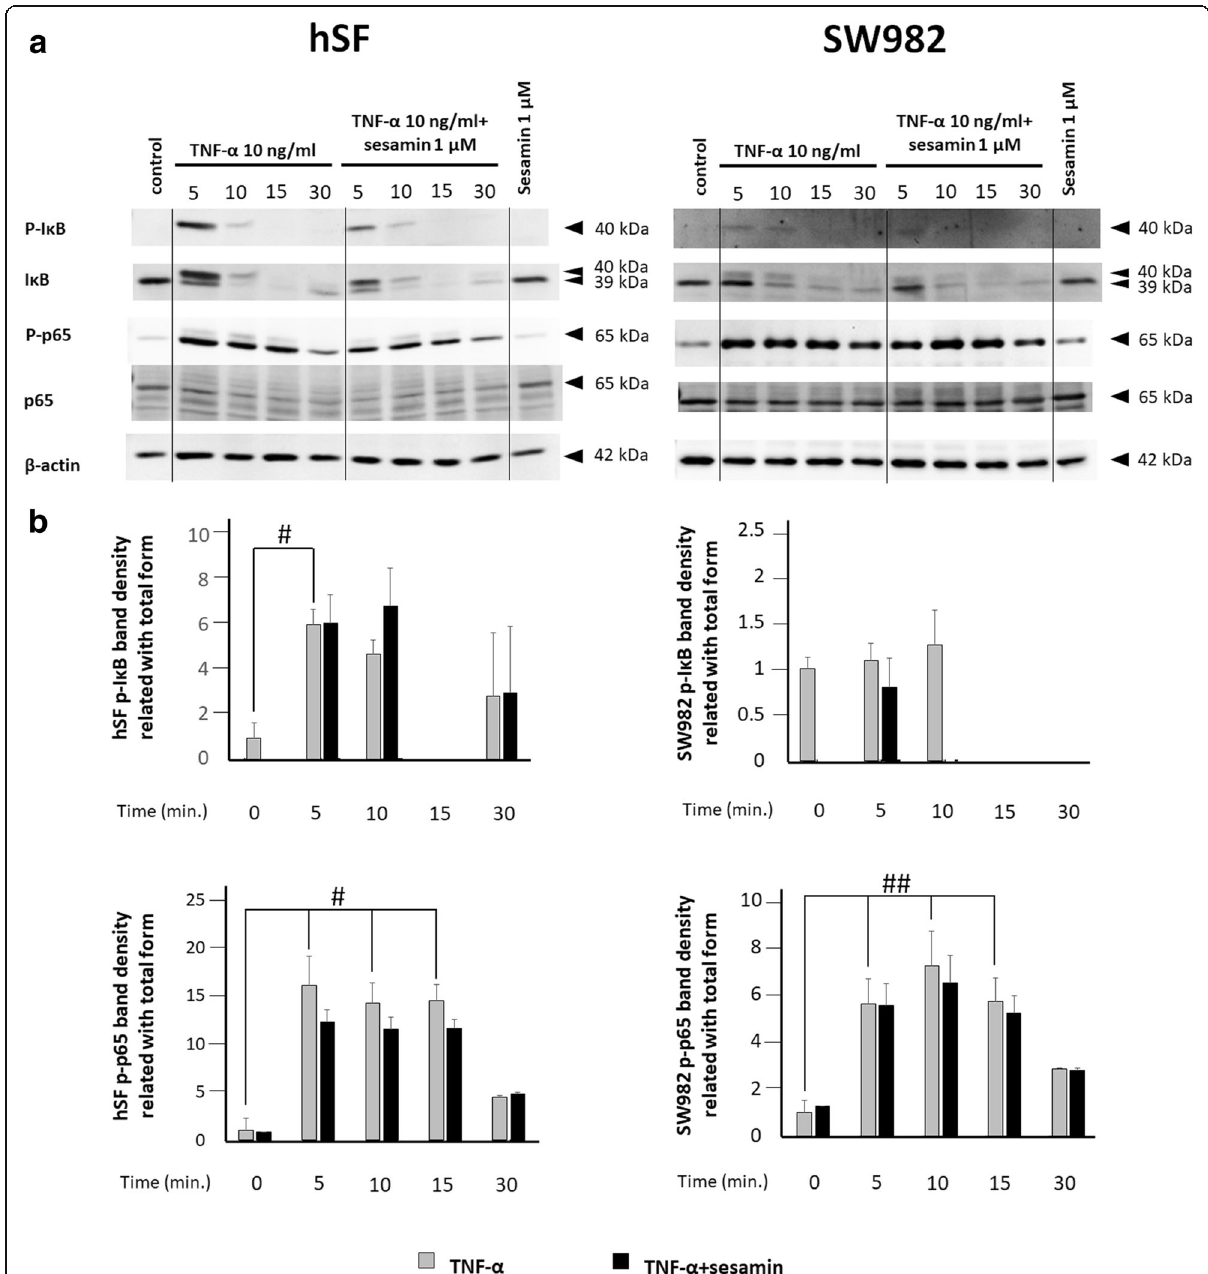
Fig. 4 Western blot analysis of NF- κ B signal transduction in hSF and SW982 cells. The NF- κ B signalling was observed l at 0, 5, 10, 15 and 30 min after the addition of TNF- α 10 ng/m to hSF or SW982 cells pre-treated with 1 μ M sesamin as described in the Materials and Methods section. a Western blot results of NF- κ B signalling in hSF and SW982 under TNF- α -induced conditions with or without sesamin treatment. b Graphs of phosphorylation band densities of I κ B and p65 relative to the total form of each cell type. Values are presented as the mean±SEM (n=3). #, * = p <0.05; ##, **= p <0.01 versus control 0 min (#) or TNF- α treatment at various time points (*) by one-way